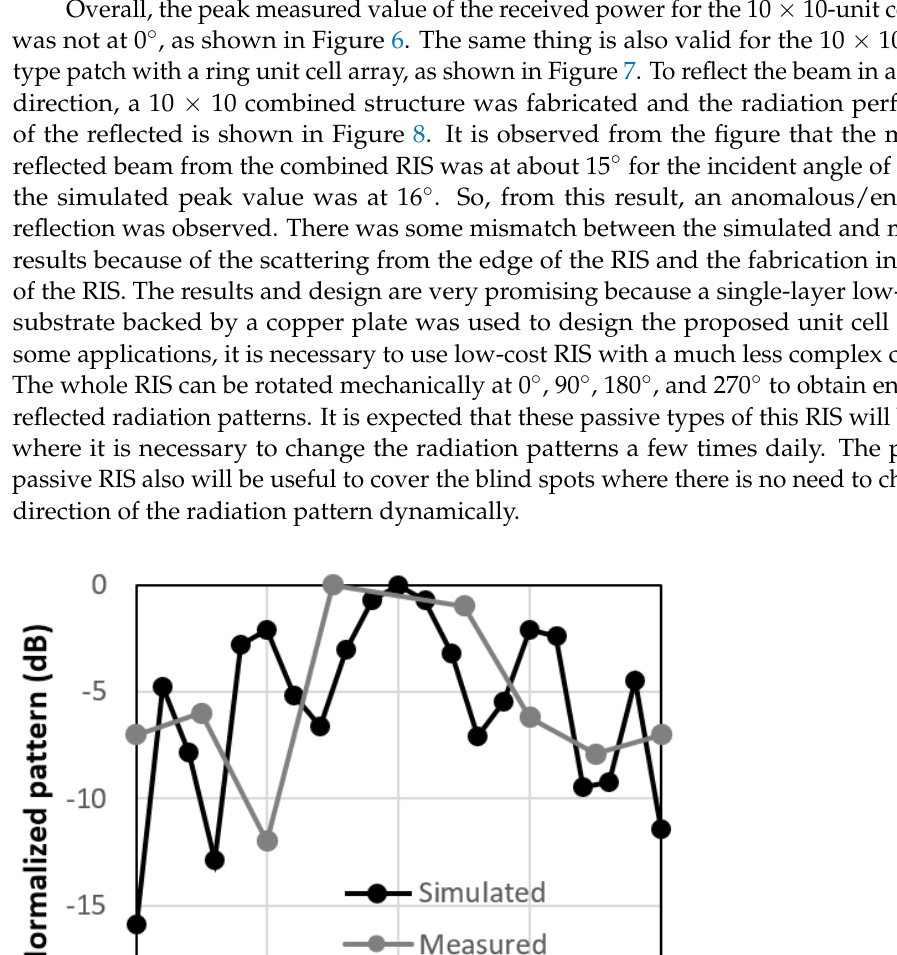
Figure 7. Normalized radiation patterns for circular patch with ring type of unit cells at 3.5 GHz.